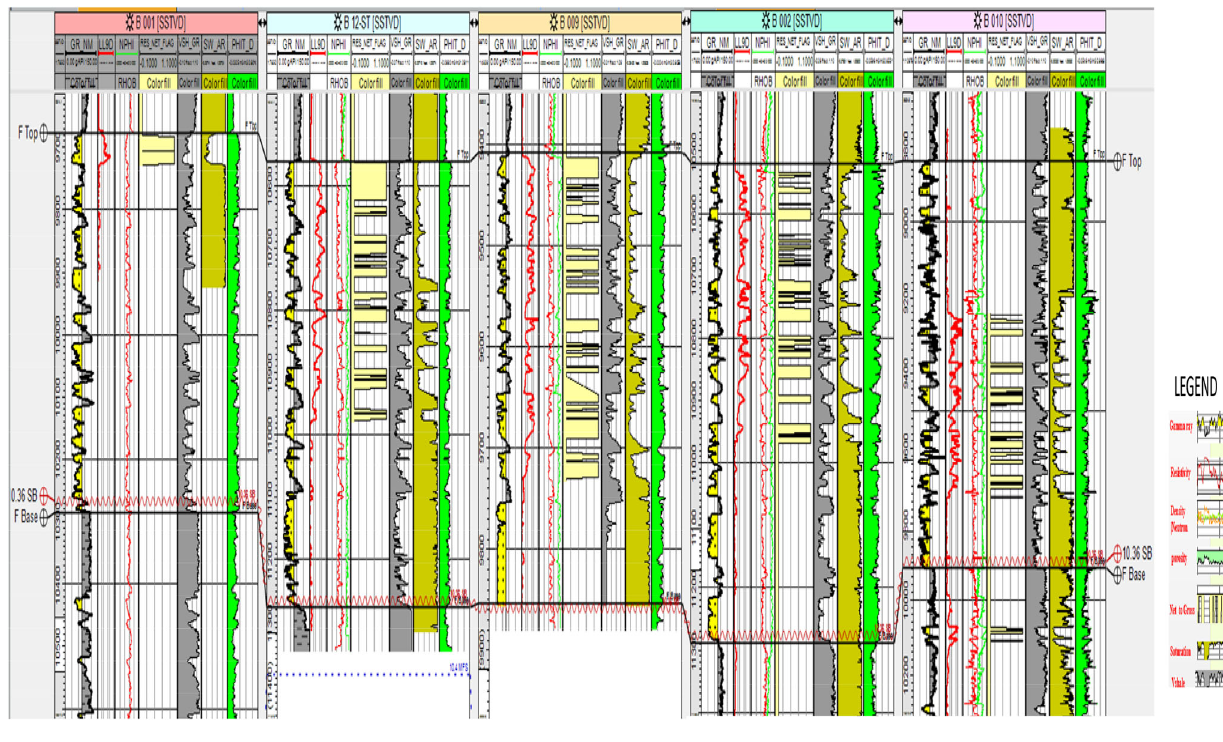
Fig. 7 Petrophysical logs generated for the F-sand reservoir